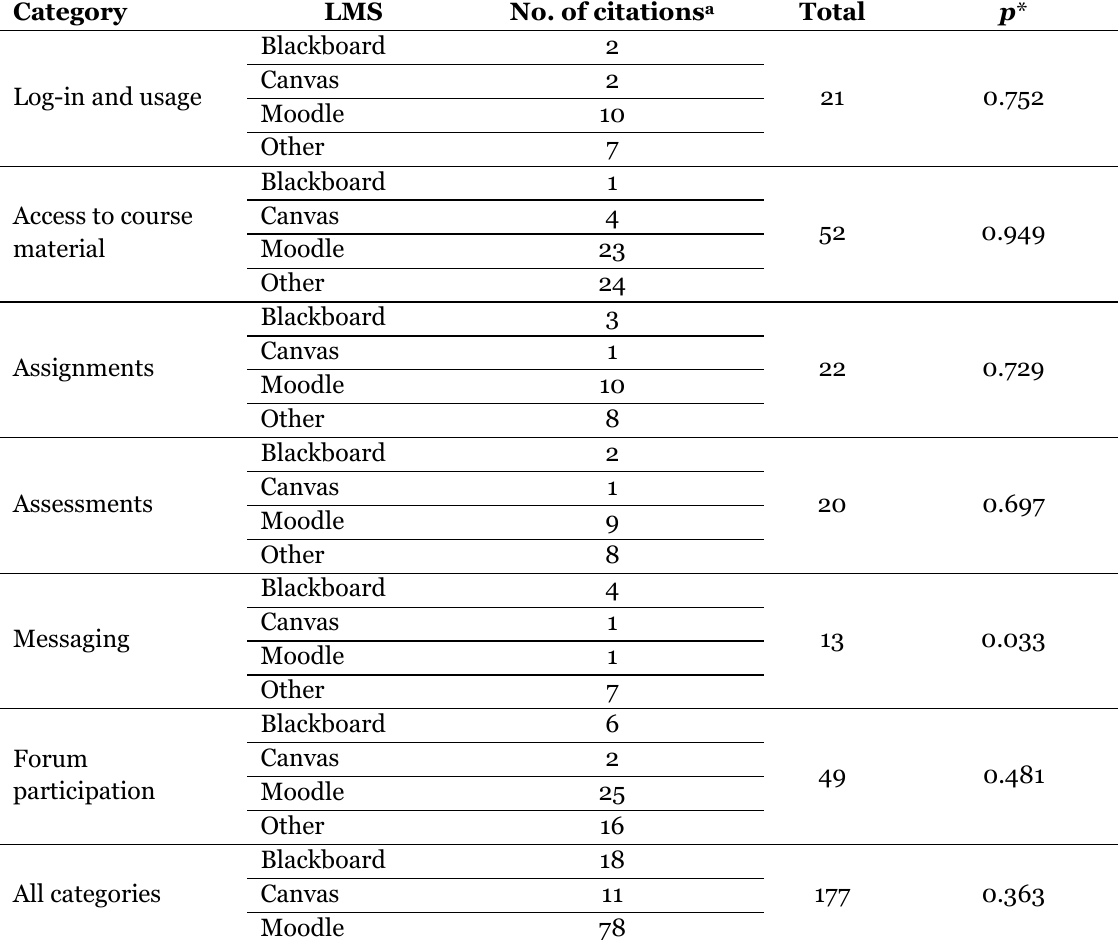
Comparison of Indicators’ Number of Citations in the Articles Related to Each LMS Type in Total and for Each